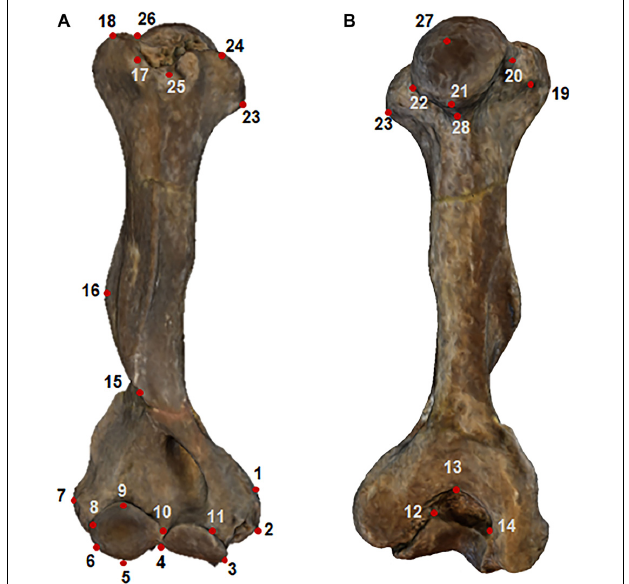
FIGURE 1 | Humerus model of Thallassocnus littoralis built using the photogrammetry method. Dots represent digitised anatomical landmarks. (A) frontal view, (B) posterior